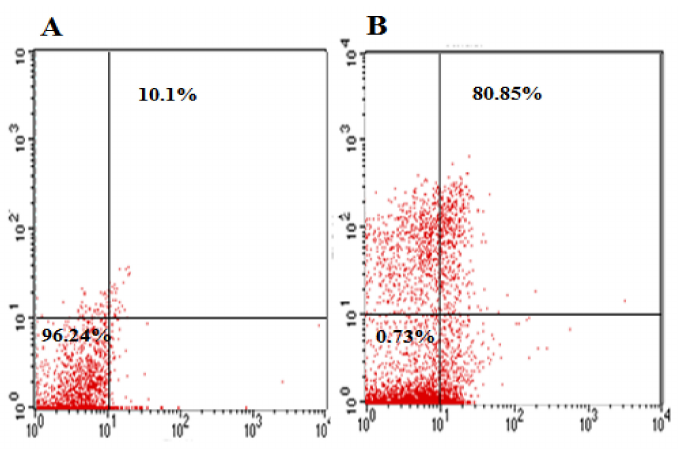
Figure 8. Flow cytometry outcomes of CIP-Ag/TiO 2 /Fe 2 O 3 /CS nanoformulation (NDDS) at MIC. ( A ) Untreated MDR E. coli cells (negative control), ( B ) treated MDR E. coli